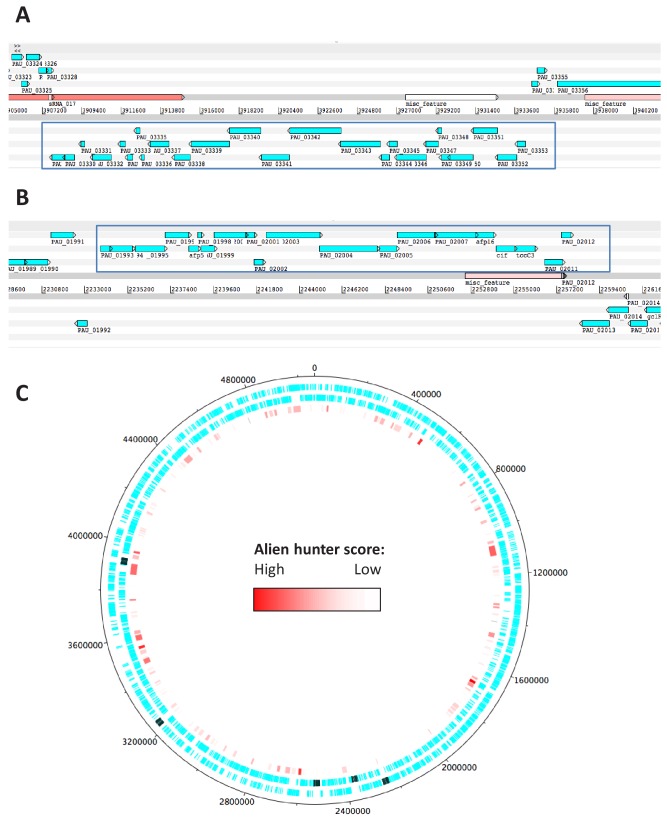
PVC operons in relation to putative regions of horizontal gene transfer as identified by Alien Hunter.(A) The PVCpnf and (B) the PVCcif operons are highlighted by the blue rectangle. Alien Hunter regions of HGT are designated by the features in tones of red. In red are the regions with the highest score and thus probability for HGT whilst in white are the regions with the lowest scores. (C) The P. asymbiotica
ATCC43949 chromosome. The first concentric circle denotes genes on the forward strand while the second circle denotes genes in the reverse strand. Black boxes represent the PVC operons. The third circle shows regions of HGT as identified by Alien Hunter.